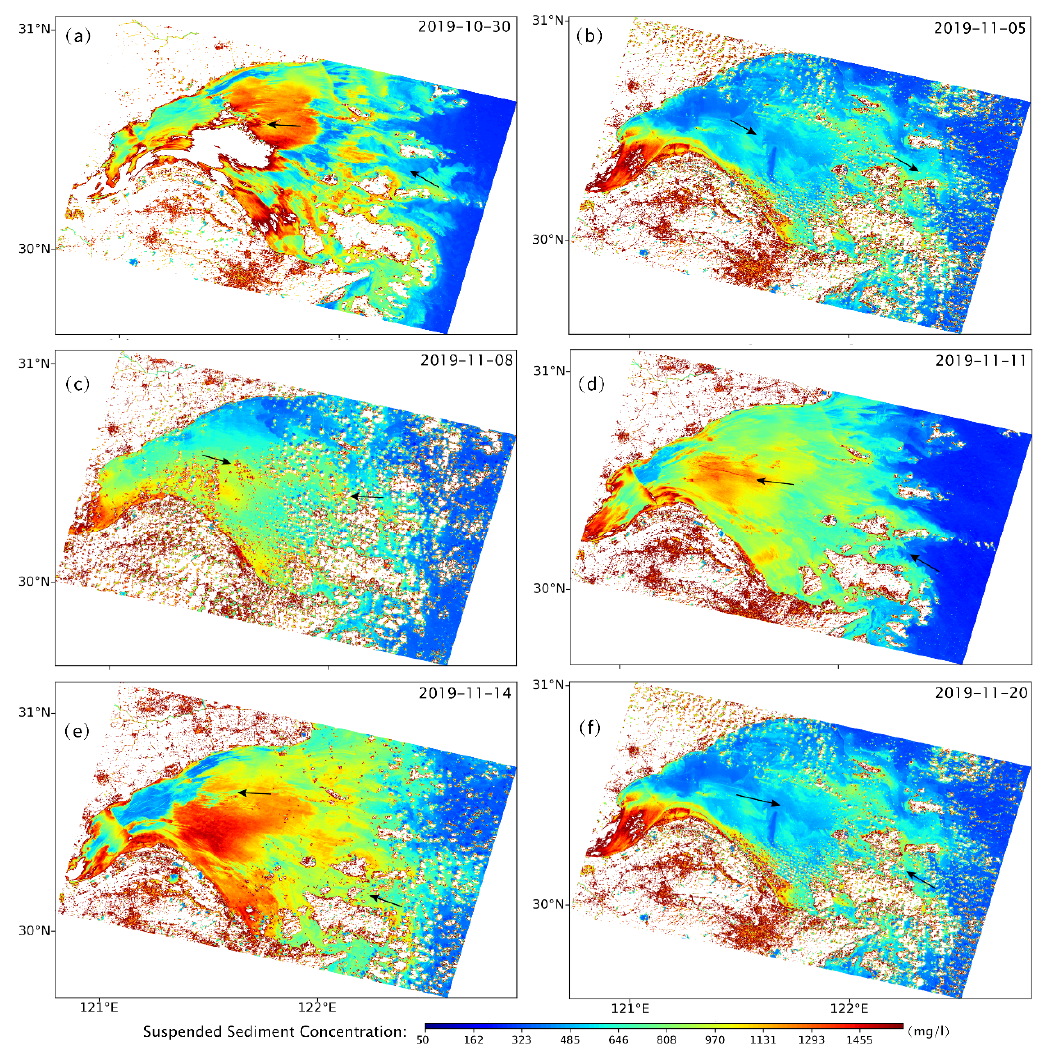
Figure 4. The distribution of SSC retrieved from 6 CZI images (Figure 4 ( a – f )) in the study area. ( a – f ) refers to satellite images of different date.